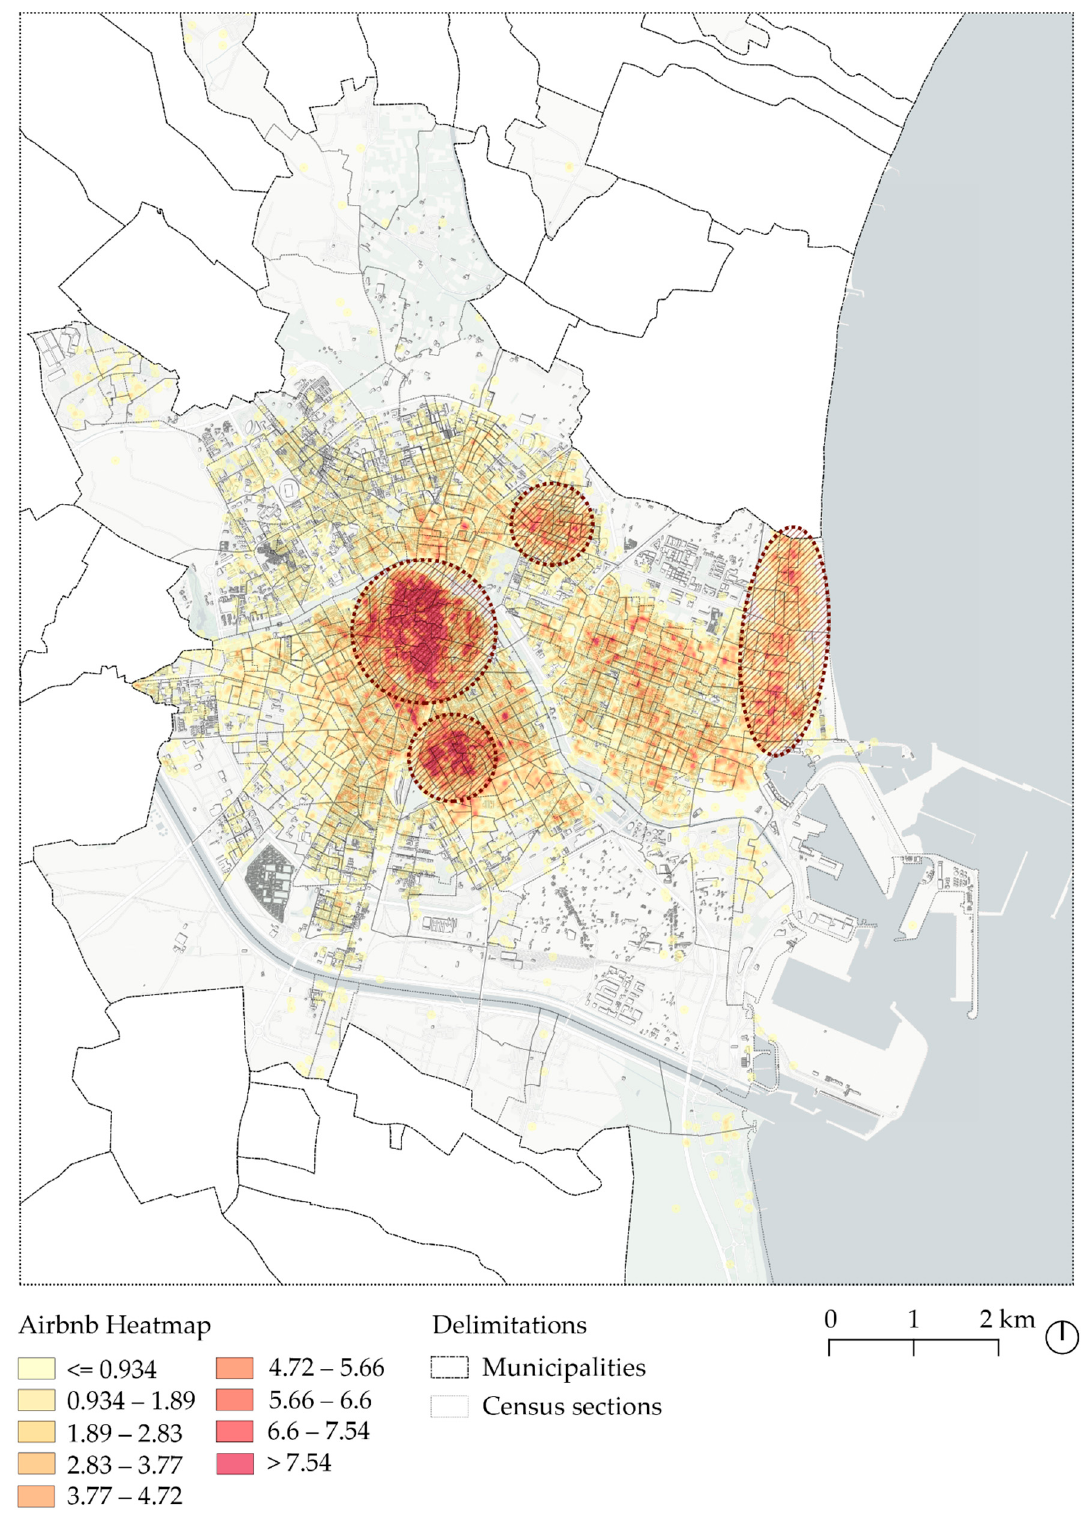
Figure 11. Airbnb properties density (heatmap).